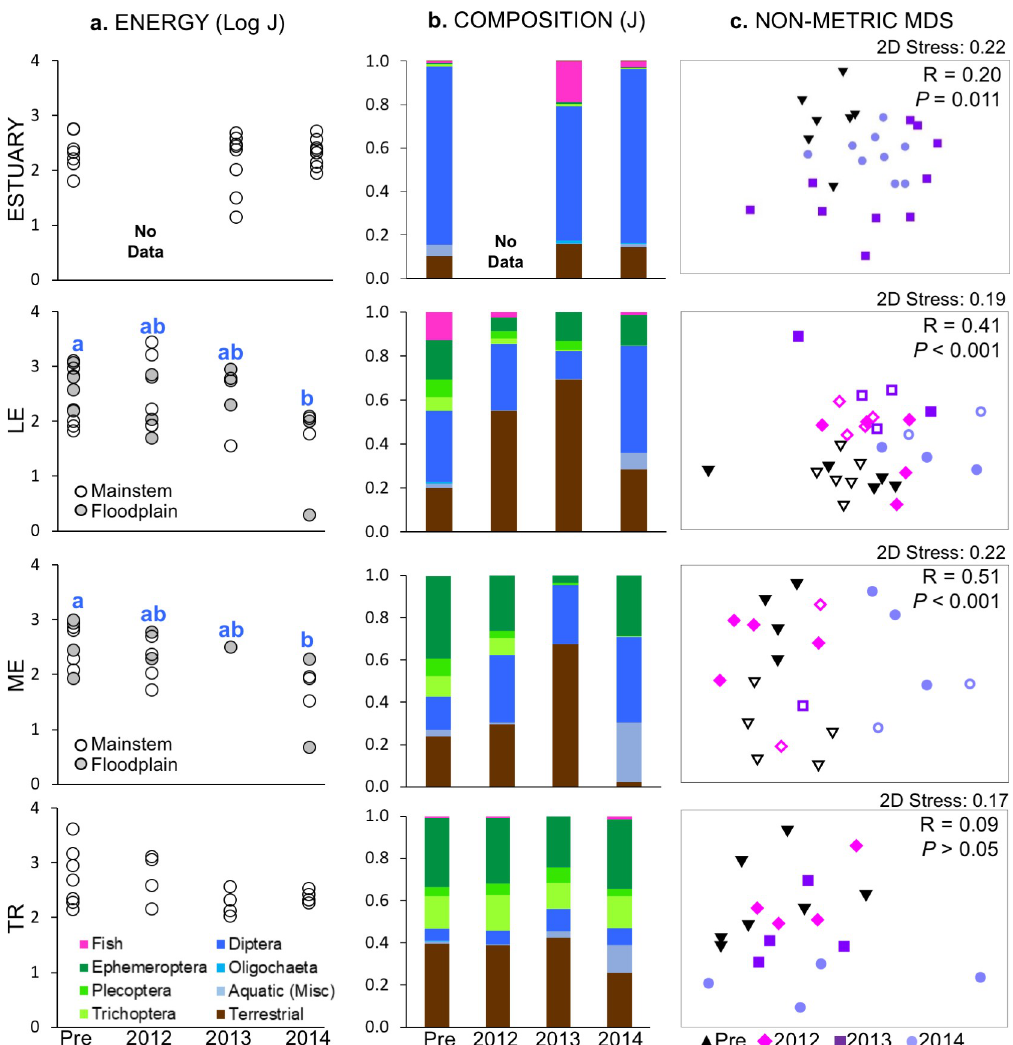
Fig 8. Summer fish diet by section and sample year. Data are plotted as (a) mean total prey energy per fish by site, (b) relative composition by major taxonomic groups (section means), and (c) nMDS, with global sample statistic and significance for one- way ANOSIM by year; note that ordinations with 2D stress values > 0.2 may not adequately represent data structure [36]. All data are in J. For panel a, different letters indicate significant year differences ( P < 0.05) within a section. For panel c, floodplain sites are indicated with outlined